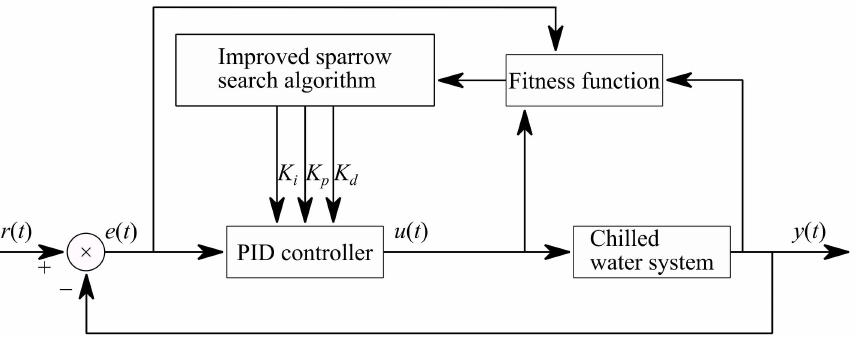
Figure 1. The block diagram of the chilled water system based on the